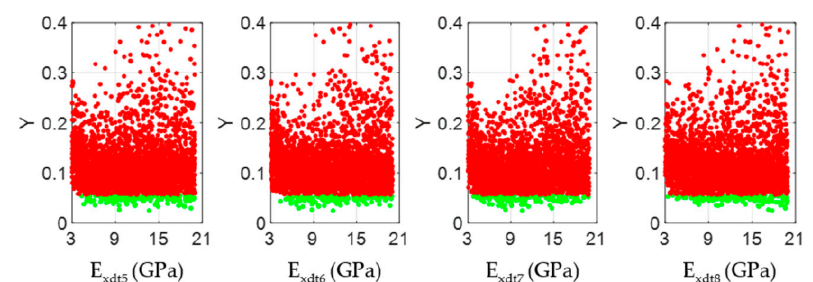
Figure 18. Scatter plots of the output samples (Y function) against the four input factors located in the central third of the timber board # 28 ( E xdt in zones 5 to 8). The green and red dots represent the sets B (behavioral) and NB (non-behavioral), respectively.